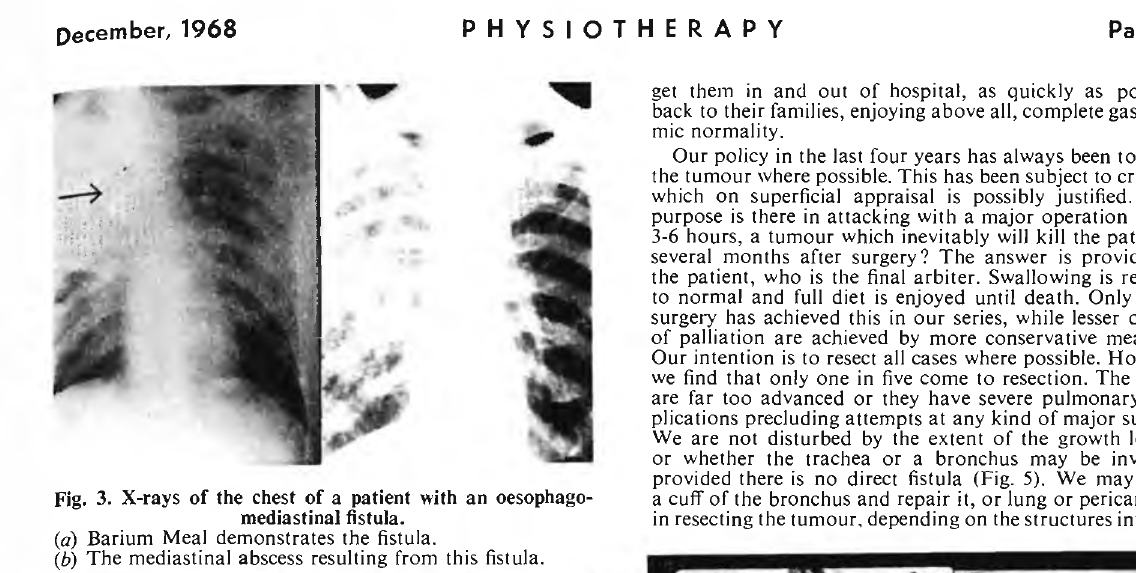
Fig. 5. Two operative specimens. (a) Showing mediastinal glands and segment of lung removed with the tumour. (b) Mediastinal and subcardinal glands removed with the